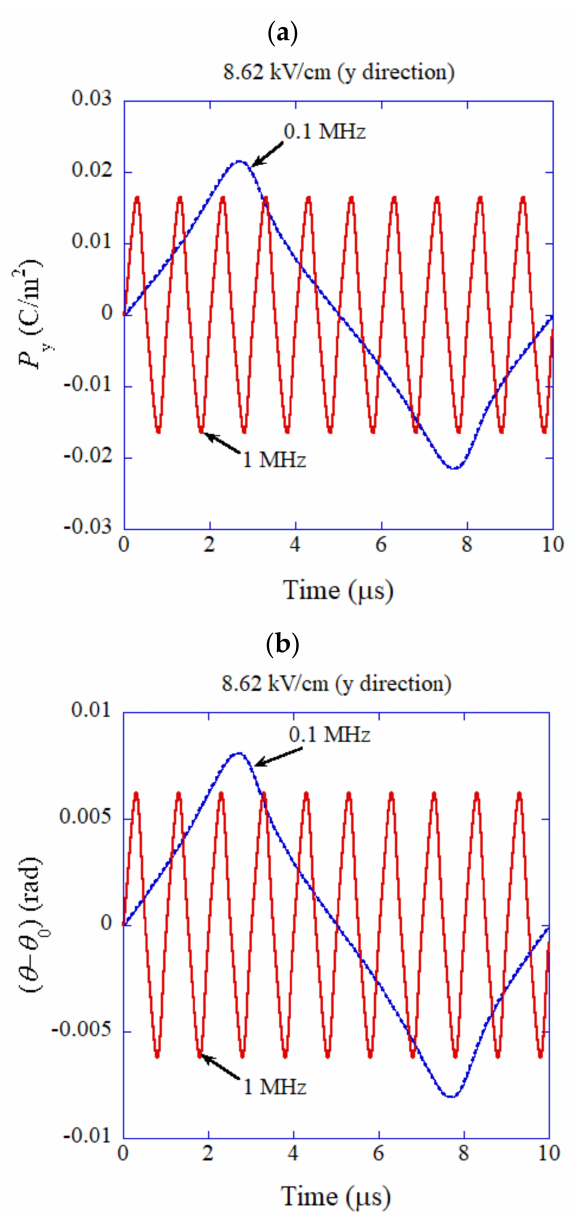
Figure 3. The results of numerical simulations for flexoelectric polarization initially perpendicular to the applied alternating electric field ( y -direction) as a function of time. ( a ) The component of polarization parallel to the applied electric field ( y -direction). ( b ) The angle ( θ ) of polarization ( θ 0 = 0 )